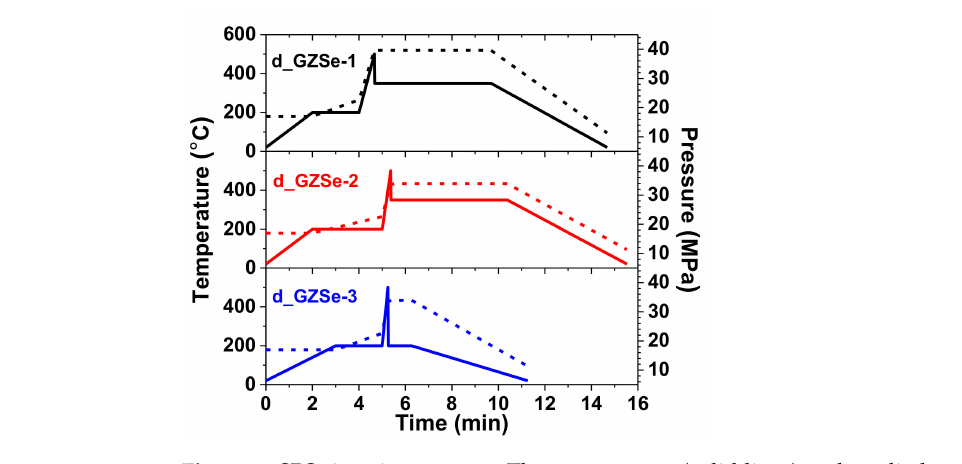
Figure 1. SPS sintering process. The temperature (solid lines) and applied pressure (dashed lines) used to densify the powders into bulk